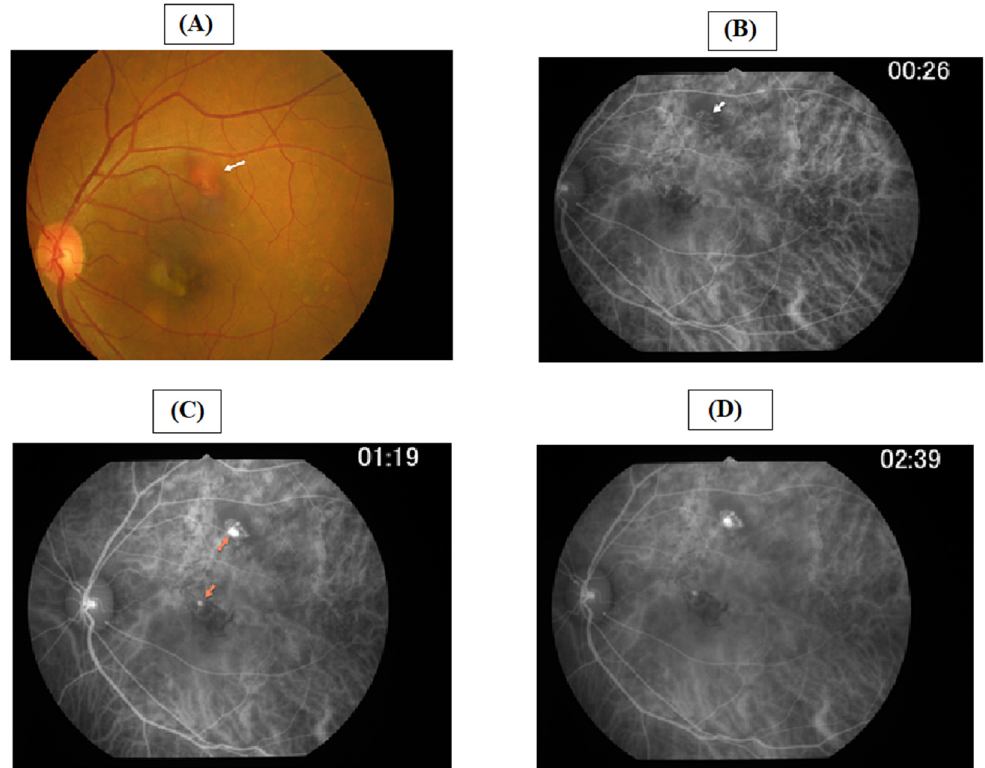
Figure 2. A representation of ICGA in a 56-year-old Vietnamese male patient with PCV in the left eye (( A ) shows one large orange-red nodule in upper temporal vessel arcade (arrow); ( B ) depicts ICGA early phase showing branching vascular network (white arrow); ( C ) represents ICGA mid-phase showing hot spots (orange arrows) and branching vascular network; ( D ) shows ICGA late phase showing hot spots).